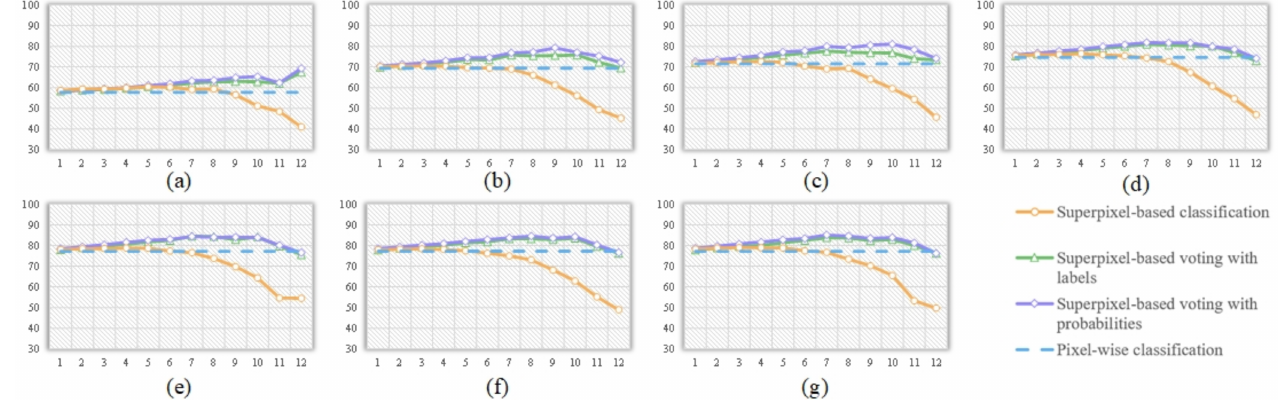
Figure 9. Accuracies given by the single-scale approaches with ( a ) 25, ( b ) 50, ( c ) 100, ( d ) 150, ( e ) 200, ( f ) 250, and ( g ) 300 training samples per class for the Hanchuan dataset using RF, where the vertical axis represents the OAs, and the horizontal axis represents the superpixel segmentation